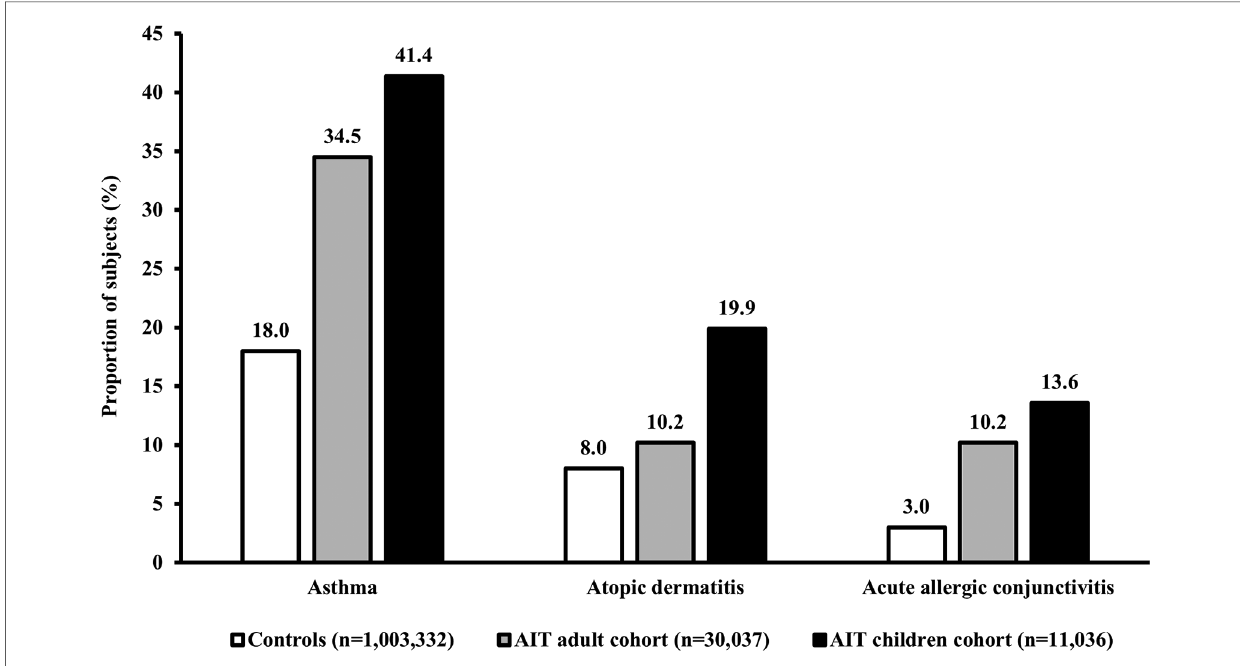
FIGURE 2 Prevalence of key atopic comorbidities in subjects with AR. Data presented are from the 1-year period before the index date (i.e., the fi rst prescription for AIT during the study period) for children and adults in the AIT group, and for control subjects (i.e., all AR subjects without prescriptions for AIT) (published previously) (47). Asthma was de fi ned based on the ICD-10 diagnostic code J45.x, or J46 and/or at least two prescriptions of SABA/ICS within an index year. AD and acute allergic conjunctivitis were de fi ned according to the ICD-10 diagnostic codes L20 – L20.9 and H10.1, respectively. AIT, allergy immunotherapy; AR, allergic rhinitis; ICD-10, International Statistical Classi fi cation of Diseases and Related Health Problems 10th Revision; ICS, inhaled corticosteroid; SABA, short-acting beta